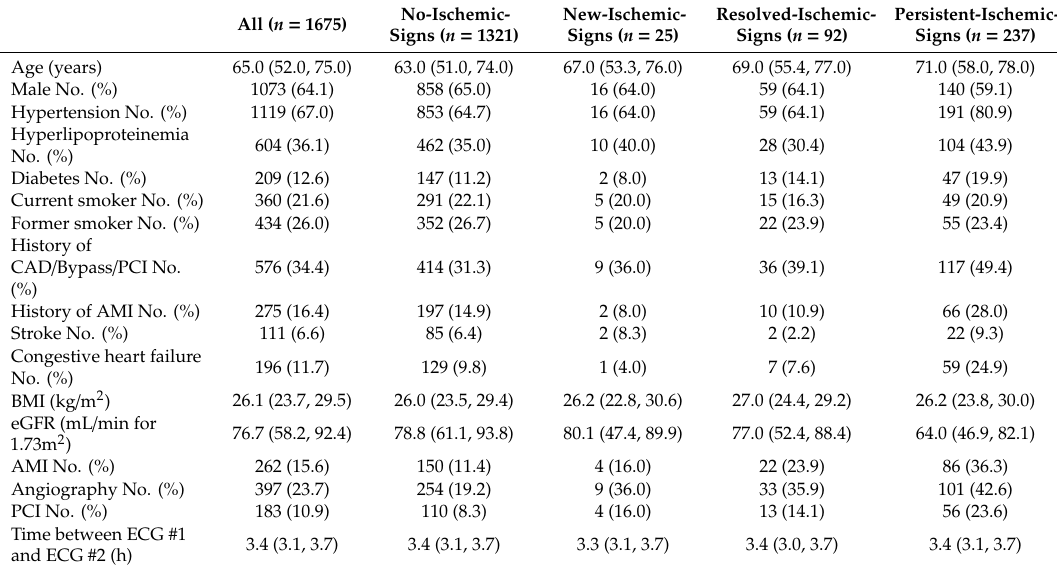
Table 1. Baseline characteristics for study population and each